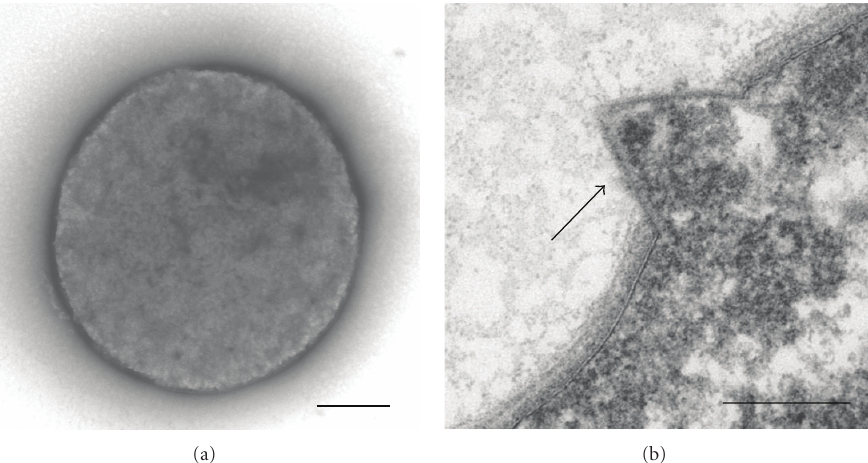
Figure 1: Electron micrographs of Sulfolobus cells (a) not infected with STIV and (b) infected with STIV; arrow indicates the STIV-induced pyramid lysis structure. Bars: 250 nm (a) and 100 nm